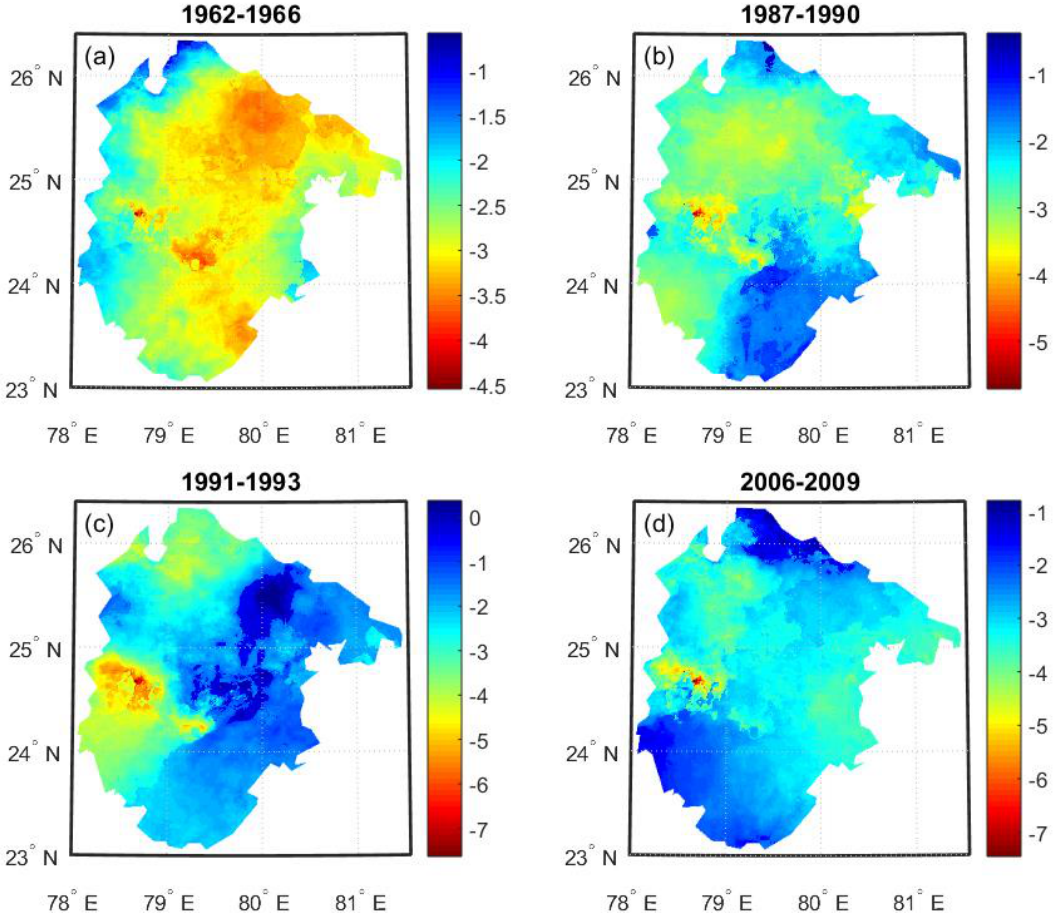
Figure 7. Various events of major droughts ( a – d ) of at least two years of duration observed in the Bundelkhand Region during 1950 to 2016. Each plot shows the averaged value of scPDSI over the drought period. The scalebar represents corresponding scPDSI units.